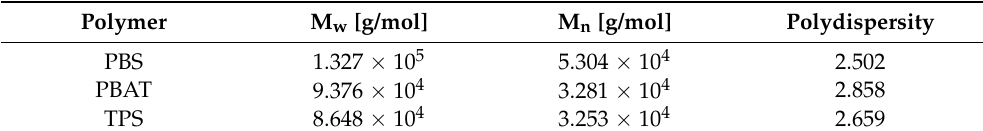
Table 5. GPC analysis of three biopolymers after rheology to determine the molecular weight (M w ), molecular weight distribution (M n ) and polydispersity.